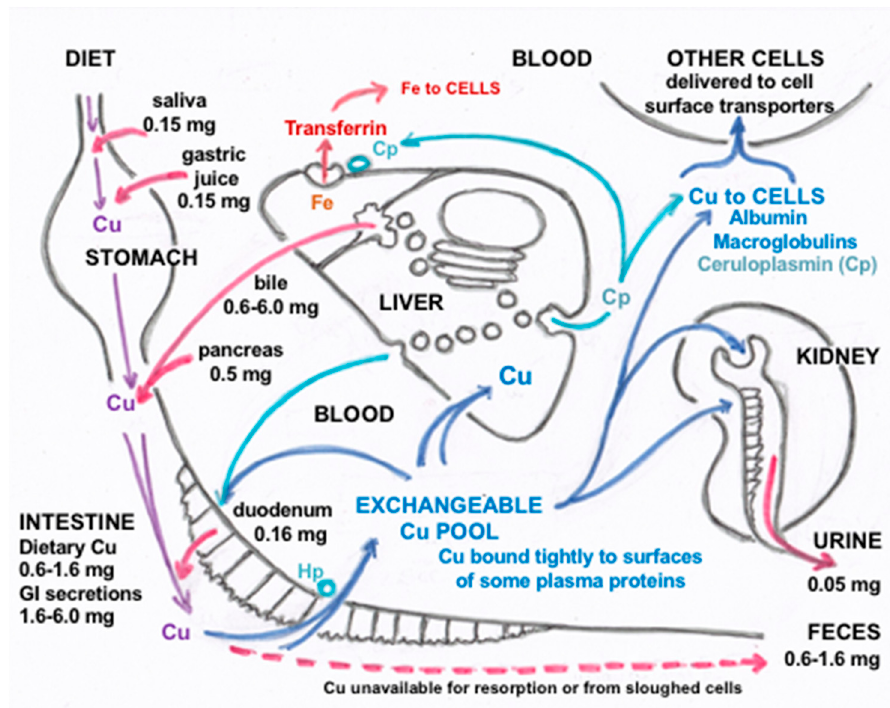
Figure 9. Overview and Summary of the homeostatic processes described in this review for the normal human adult. This figure diagrams amounts of copper entering the digestive tract from various sources and how they travel from the intestine to key organs (like liver and kidney) and the rest of the organism, as well as how copper is excreted. Values indicated are average mg Cu per day. Dietary Cu is indicated by purple lines; absorption and distribution to liver, kidney and other cells is in darker blue; involvement of ceruloplasmin (Cp) is in lighter blue; involvement of Cp and hephaestin (Hp) in Fe efflux from liver and intestine, respectively, is in the light blue and orange; secretions that lead to Cu efflux into the GI tract, feces and urine are in red. Modified and updated from Linder [9].